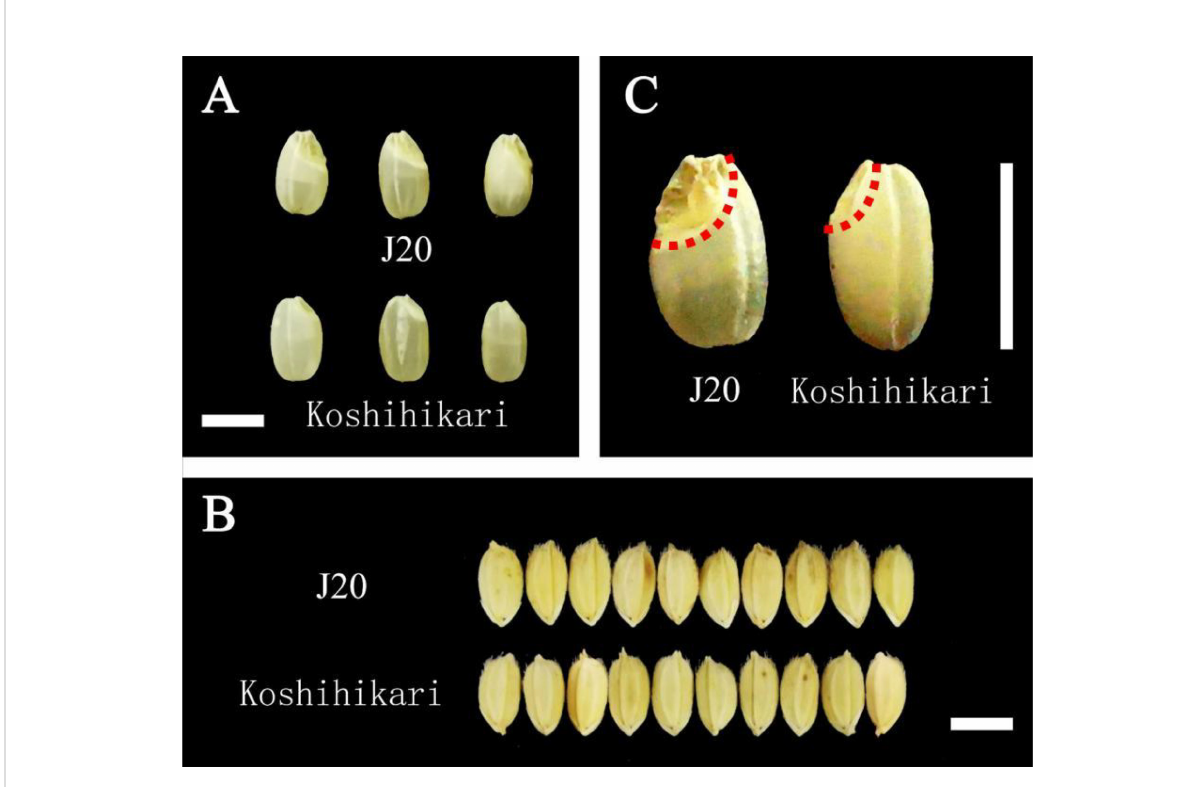
FIGURE 1 Comparison of grain types between J20 and Koshihikari. (A) Comparison of J20 and Koshihikari brown rice; (B) Comparison of J20 and Koshihikari grains; (C) J20 compared with Koshihikari brown rice embryo. The scale bar is 5